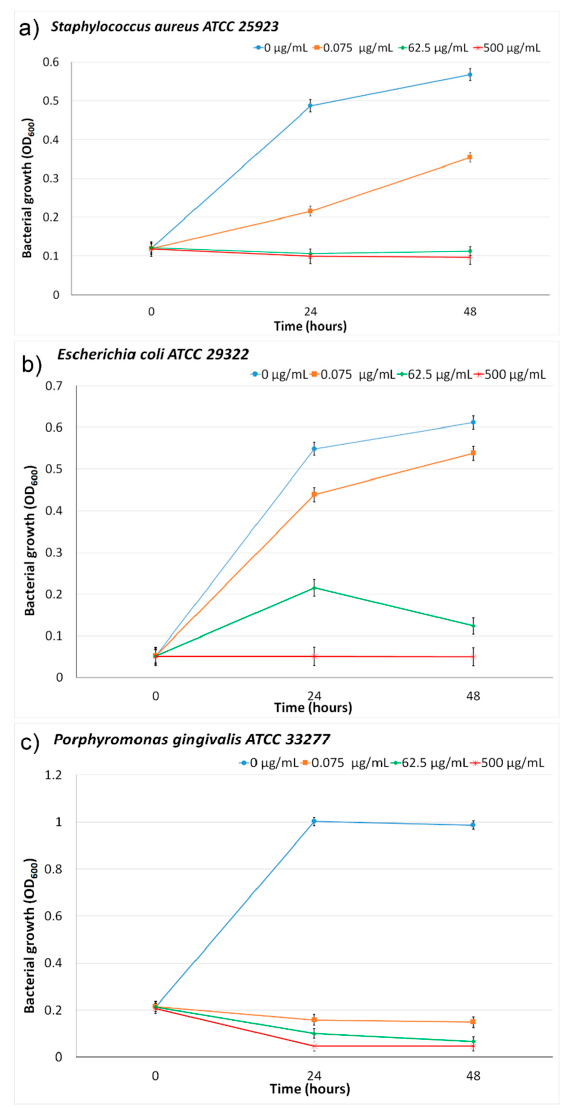
Figure 14. Inhibitory effects of ZnHApD solution on the growth of bacteria (mean ± SD). Staphylococcus aureus ATCC 25923 ( a ), Escherichia coli ATCC 25922 ( b ) and Porphyromonas gingivalis ATCC 33277 ( c ) at 24 and 48 h.